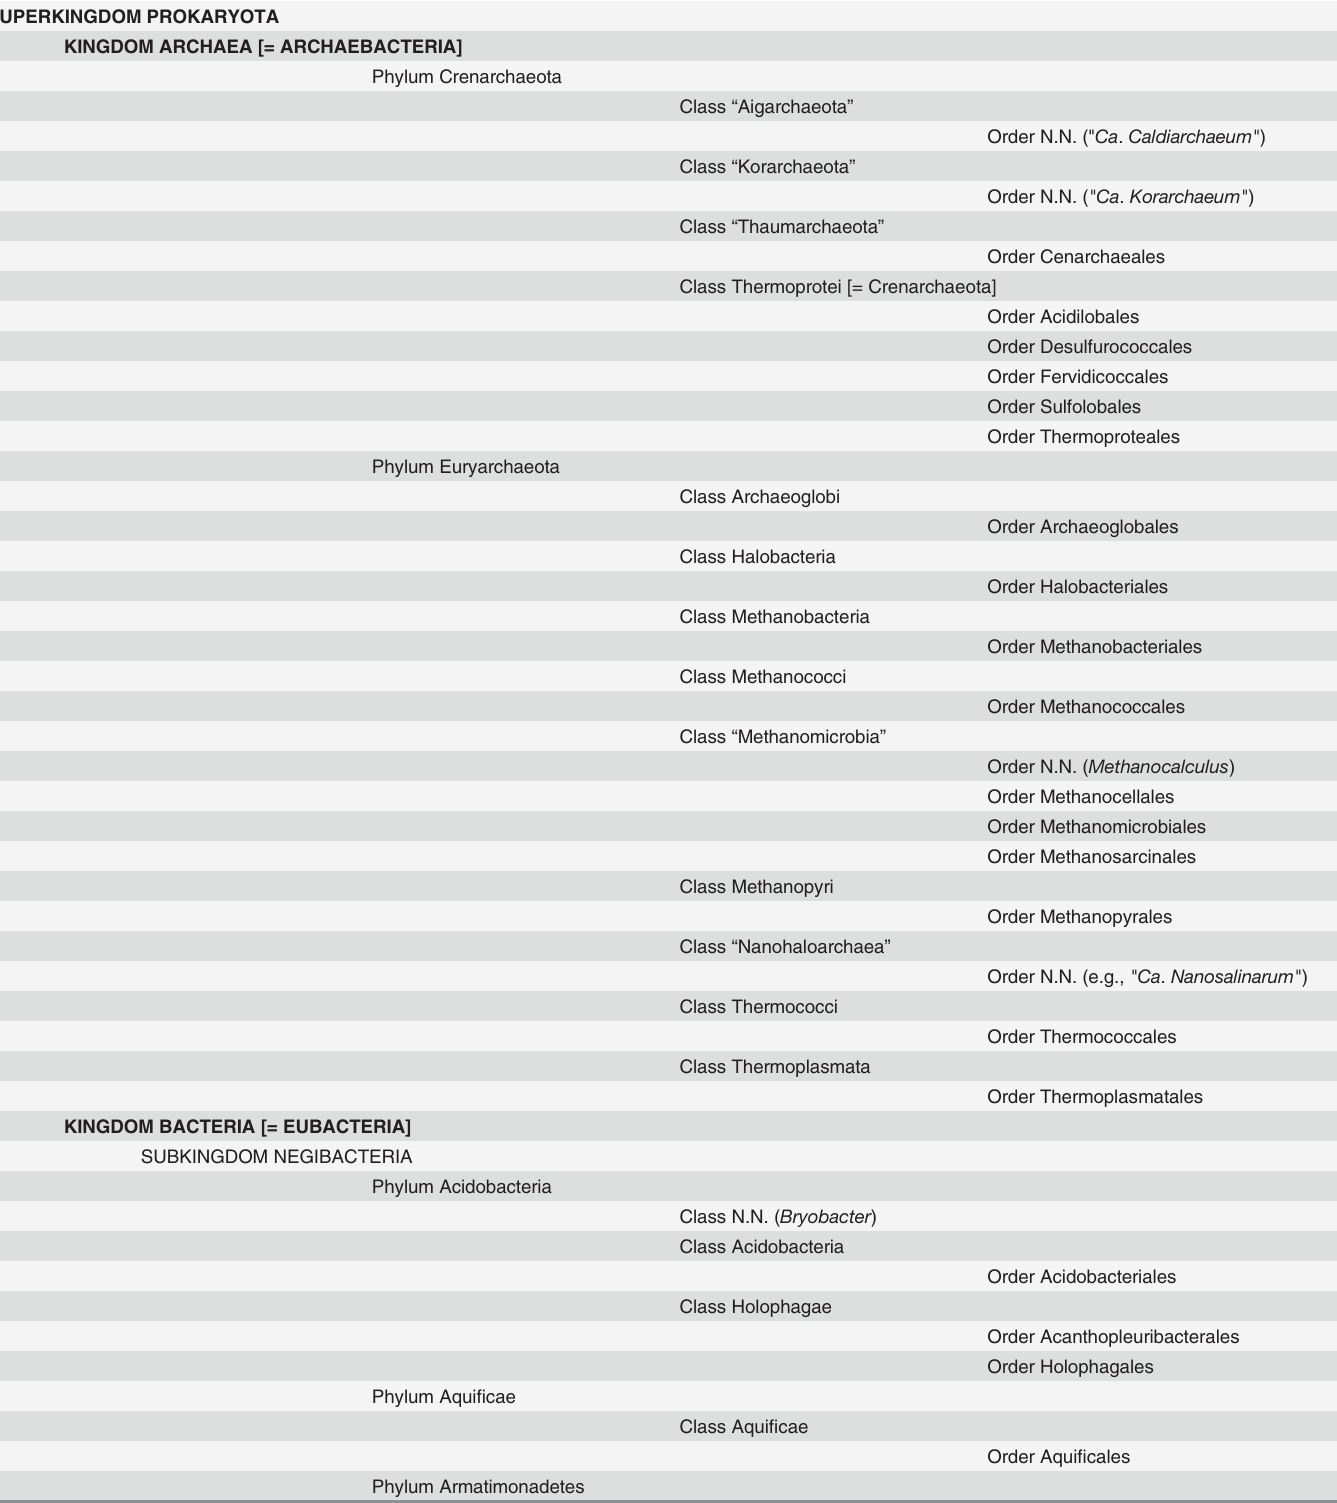
Table 2. Proposed hierarchical classification from superkingdom to